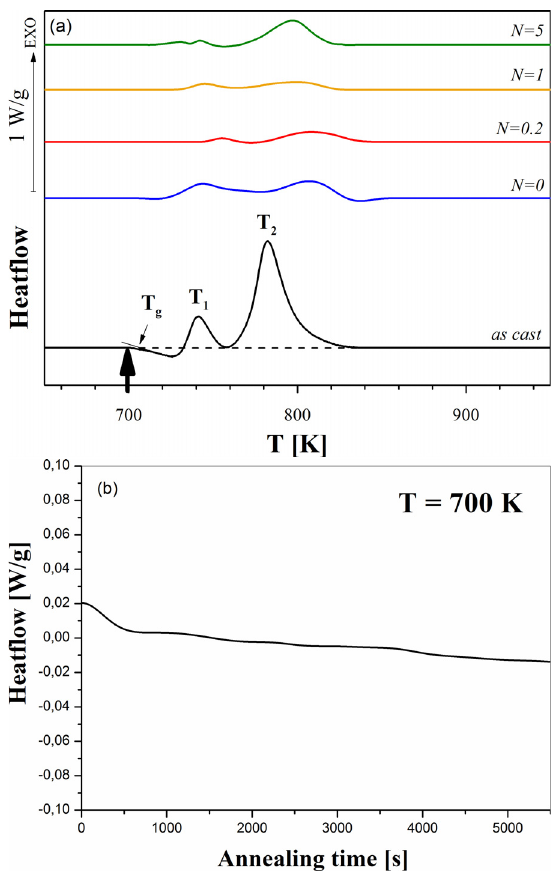
Figure 2: (a) DSC curves of as-cast, compressed (N=0) and different (N=0.2, 1, 5) HPT deformed Cu 60 Zr 20 Ti 20 samples. The T g glass transition and the T 1 and T 2 crystallization peak temperatures are indicated on the as-cast curve. (b) Isothermal annealing obtained on the as-cast BMG at T ann =700K.